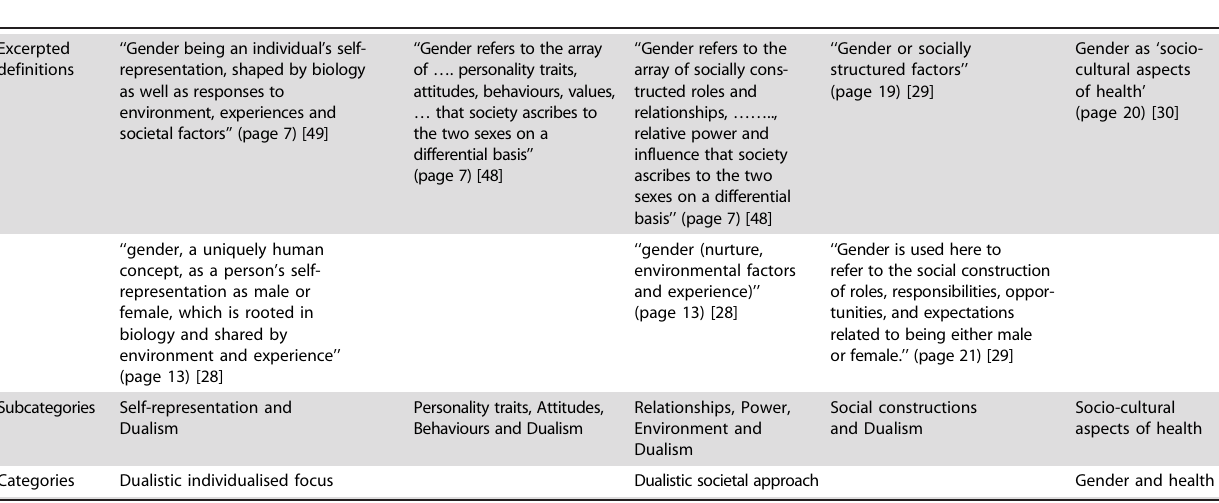
Table 4. Excerpted definitions, subcategories and categories in the qualitative coding of the concept